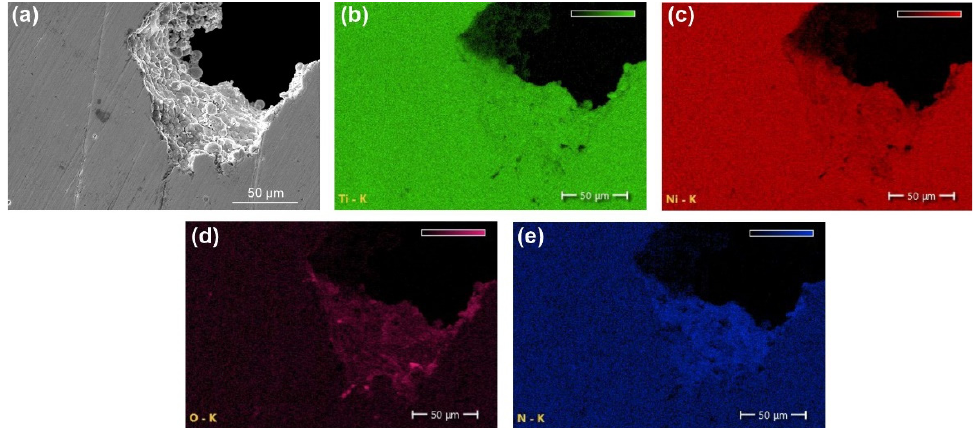
Figure 9. Energy-dispersive analysis of the interpore bridge of porous NiTi-(N) alloy: ( a ) SEM image, and ( b ) Ti, ( c ) Ni, ( d ) O, and ( e ) N maps.